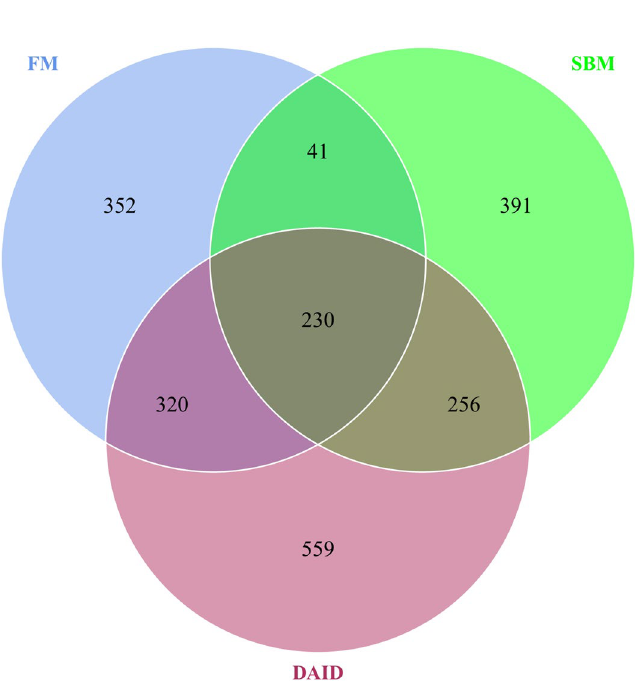
Figure 5. Venn diagram of intestinal microbiota. FM fish meal diet, SBM soybean meal diet, DAID 40 mg/kg daidzein included into SBM